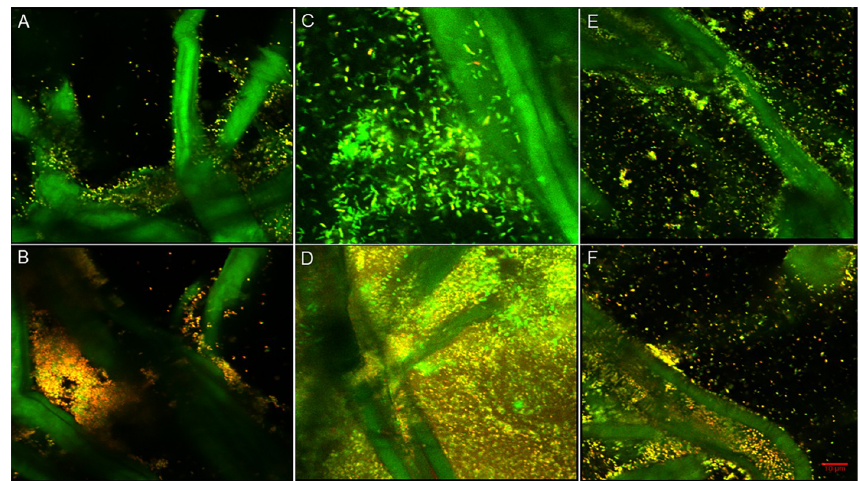
Fig 5. Single section CLSM (60x magnification) images collected using BacLight ™ Live/Dead stain to determine whether CZ-01179 (2%) affected biofilms on the bottom as well as top of portions of cellulose discs. Cellulose fibers stained green along with live cells. (A) MRSA biofilm on the bottom (non-treated) side of a cellulose disc. The majority of cells stained green (living), suggesting limited activity against the biofilms in that region. (B) MRSA biofilm on the top (treated) side of a cellulose disc. The predominance of red indicated that there was significant antimicrobial activity against biofilms in that region. (C) P . aeruginosa biofilm on the bottom (non-treated) side of a cellulose disc. The predominance of green stain suggested very little, if any activity was present against the biofilms. (D) Biofilm of P . aeruginosa on the top (treated) side of a cellulose disc. The majority of cells stained red, suggesting significant antimicrobial activity, in particular compared to the untreated side. (E) Polymicrobial biofilms on the bottom (non- treated) side of a cellulose disc. The lack of red/yellow indicated little to no antimicrobial activity had occurred. (F) Polymicrobial biofilms on the top (treated) side of a disc. The majority of cells stained red, suggesting that CZ-01179 was effective at eradicating polymicrobial biofilms on the top portions of cellulose discs.